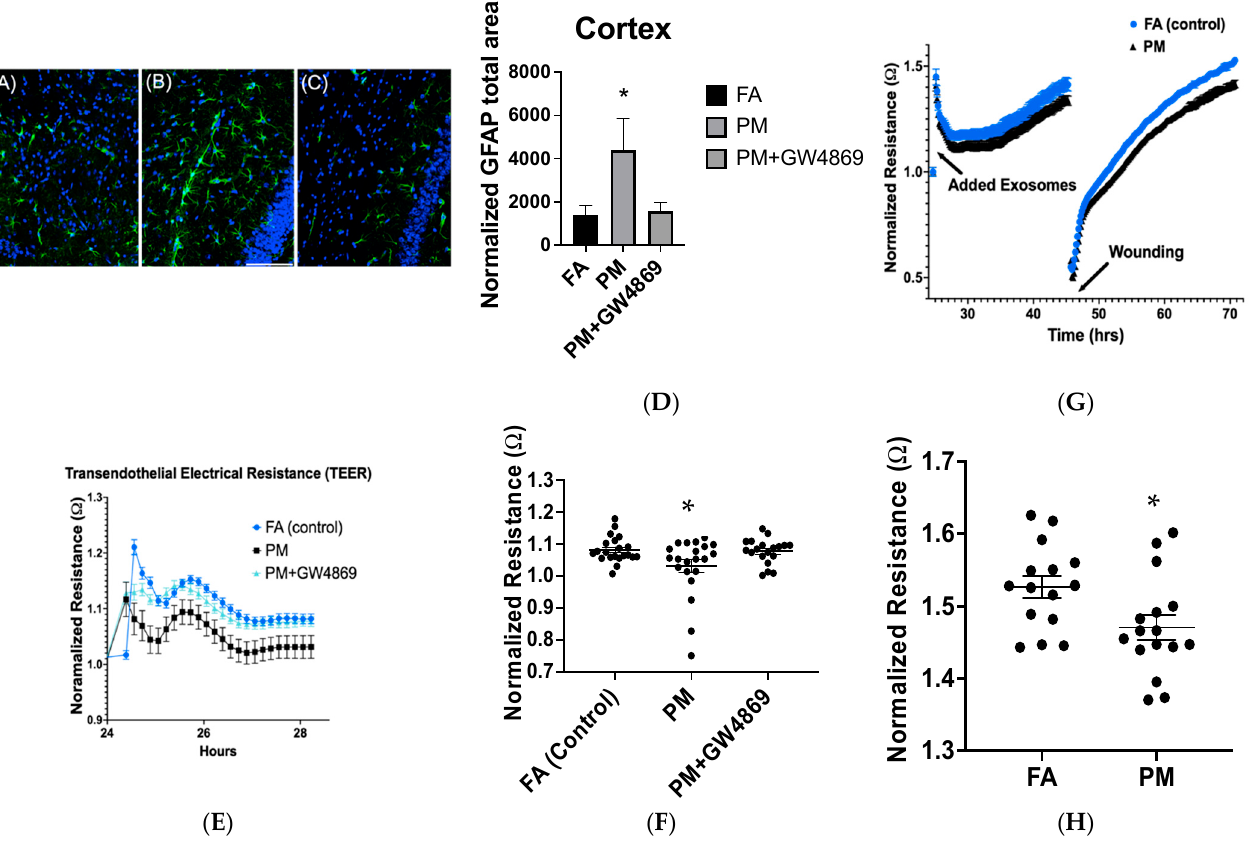
Figure 4. Cerebrovascular integrity. Representative images of brain cortex sections ( A – C ) stained with DAPI (nuclear staining, blue) and normalized GFAP staining (green) in FA, PM, and PM + GW4869 treatment groups with respective quantification ( D ). Transendothelial electrical cell impedance sensing (ECIS) in cerebrovascular endothelial cells treated with 5% serum from the aforementioned exposure treatment groups ( E , F ). There was significant ( p = 0.02) diminished resistance in vascular endothelial integrity following serum treatment, suggesting endothelial leakage in the PM group, which was mitigated with GW4869, according to a one-way ANOVA. ( G , H ) Transendothelial resistance following treatment with solely exosomes and cell culture wounding (scratch assay) with regrowth ( p = 0.01). Data are considered significant at p ≤ 0.05, as indicated by the asterisk (*). Data represent the mean ± SEM.